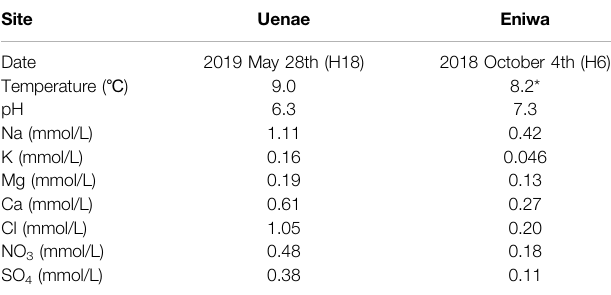
TABLE 1 | Temperature, pH and chemical compositions of groundwater samples in Hokkaido, Japan.